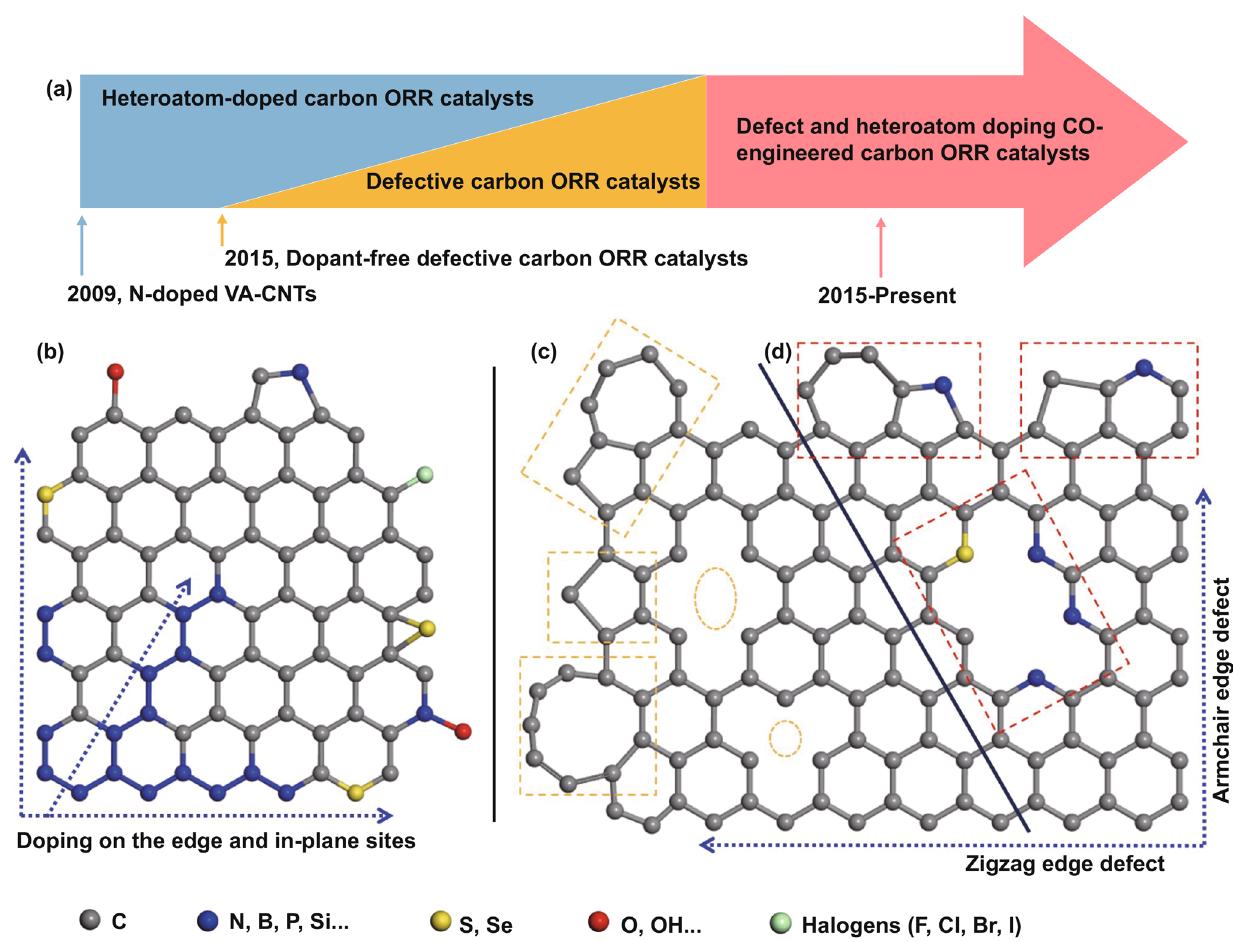
Fig. 1 a Timeline showing the important developments of various functionalized non-metal carbon-based ORR electrocatalysts. Schematic illustration of the representative configurations: b heteroatom doping engineered carbon. c Defect-inducing engineered carbon. d Defect- and heteroatom co-engineered